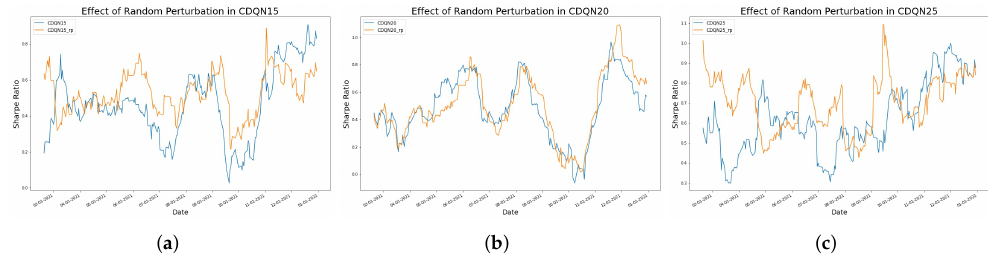
Figure 8. The effect of random perturbation measured by Sharpe ratio for FB. ( a ) The left figure shows the comparison between the Sharpe ratio curves with or without the random perturbation technique in CDQN15. ( b ) The middle figure shows the comparison between the Sharpe ratio curves with or without the random perturbation technique in CDQN20. ( c ) The right figure shows the comparison between the Sharpe ratio curves with or without the random perturbation technique in